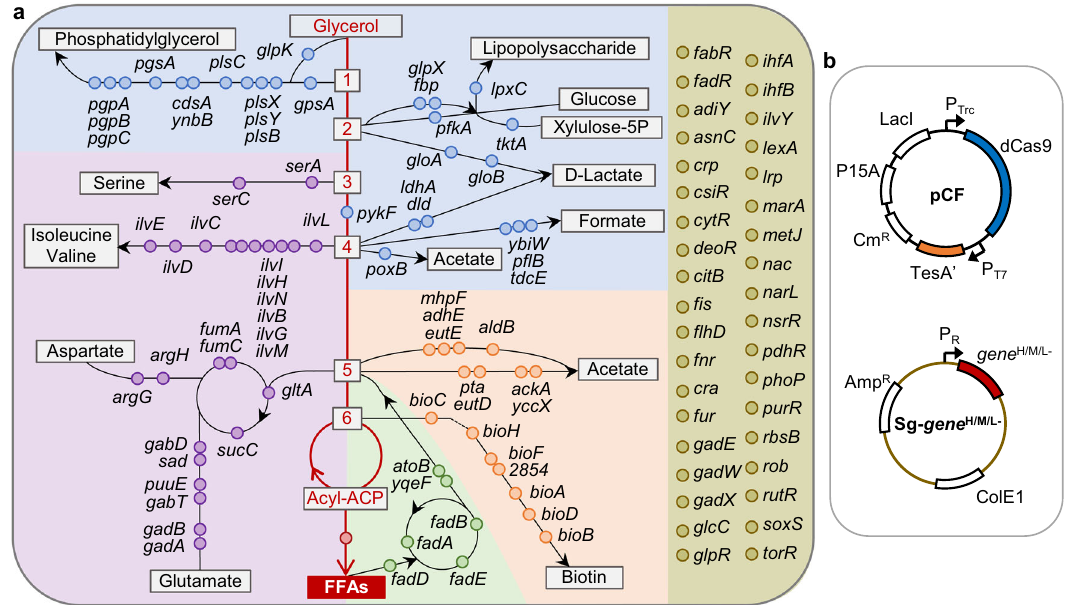
Fig. 1 Gene targets related to FFA metabolism that were selected for modulation by the CRISPRi system. a Schematic of the metabolic or regulatory pathways related to FFA biosynthesis in E. coli BL21(DE3), which were classi fi ed into fi ve modules, namely, upstream carbon fl ux diversion, downstream carbon fl ux diversion, amino acid metabolism, beta-oxidation, and transcription factor, represented in blue, orange, purple, green, and golden backgrounds, respectively. The 108 candidate genes in the above fi ve modules are marked with blue, orange, purple, green, and golden dots, respectively (see Supplementary Data 1). 2854 represents the gene numbered ECD_02854 in BL21(DE3). The fatty acid biosynthetic pathway is shown as a red line, from glycerol to acyl-ACP and conversion to FFAs by TesA ′ (encoded by the tesA ′ gene marked with a red dot). The key metabolites glycerone-P, glyceraldehyde-3P, glycerate-3P, pyruvate, acetyl-CoA, and malonyl-ACP are represented as numbers 1 to 6, respectively. b Plasmid constructs for the expression of tesA ′ , dCas9 and the sgRNAs gene H/M/L − . Cm R , chloramphenicol-resistance gene; Amp R , ampicillin-resistance gene; P15A and ColE1, replication